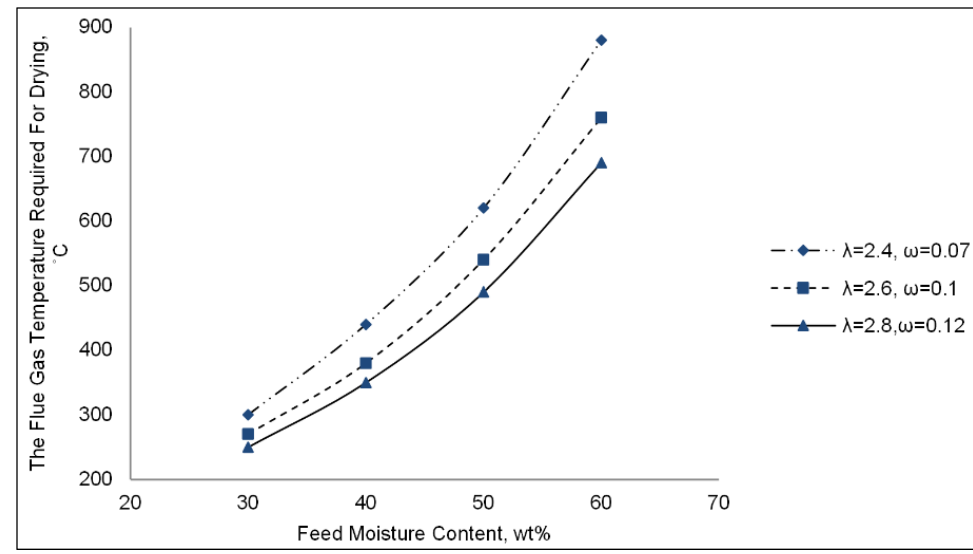
Figure 11. The effect of feed moisture content on the flue gas temperature required for drying, T = 850 °C and S / B = 0.84.